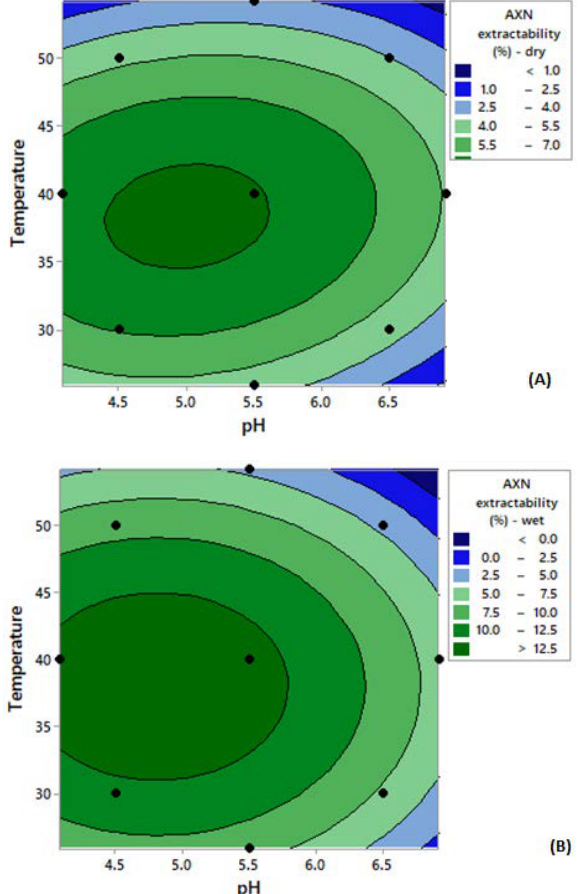
Figure 4. Contour plots depicting the e ff ect of temperature and pH on astaxanthin extractability from X. dendrorhous cells following Accellerase 1500 treatment on ( A ) dry cells and ( B ) wet cells. * The black dots on the contour plot represent the experimental points. Abbreviation: